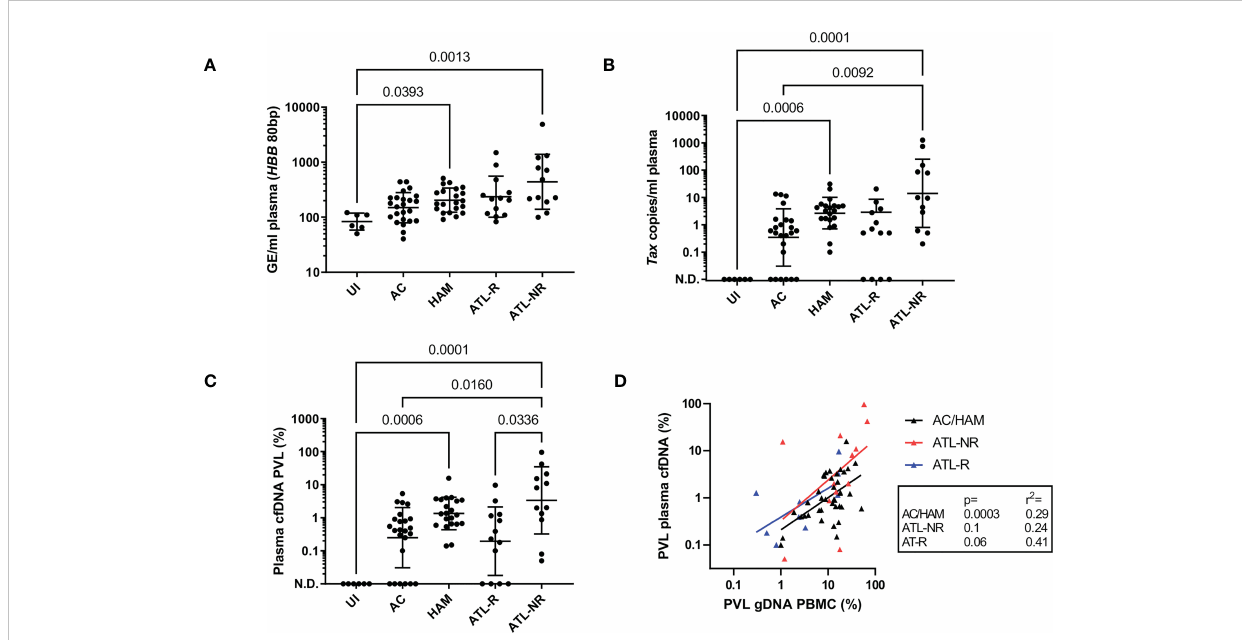
FIGURE 2 Detection of HTLV-1 in plasma cfDNA from HTLV-1 carriers. qPCR was used to quantify the copy number of Tax and HBB in plasma cfDNA and PBMC gDNA in blood donated by six uninfected controls, 24 ACs, 21 patients with HAM and 25 patients with ATL. Patients with ATL were either in remission (ATL-R, n=12) or were untreated, had stable disease or were being treated and had signi fi cant residual disease (Not in Remission, ATL-NR, n=13). (A) Genome equivalents (GE) per ml of plasma for each group were measured by quantifying the number of copies of HBB (80 bp PCR product). (B) Tax copies/ml of plasma (58bp PCR product). N.D. indicates not detected. (C) Plasma cfDNA PVL. PVL was calculated with the following formula: PVL= ( Tax copies/GE( HBB 80bp))*100. (D) Simple linear regression of the PBMC genomic DNA (gDNA) PVL versus plasma cfDNA PVL in the AC/HAM, ATL-R and ATL-NR groups. Lines and error bars indicate the geometric mean and geometric SD. Statistical tests: Kruskal-Wallis with Dunn ’ s multiple comparisons test (two-tailed, 95% con fi dence interval, GraphPad Prism).